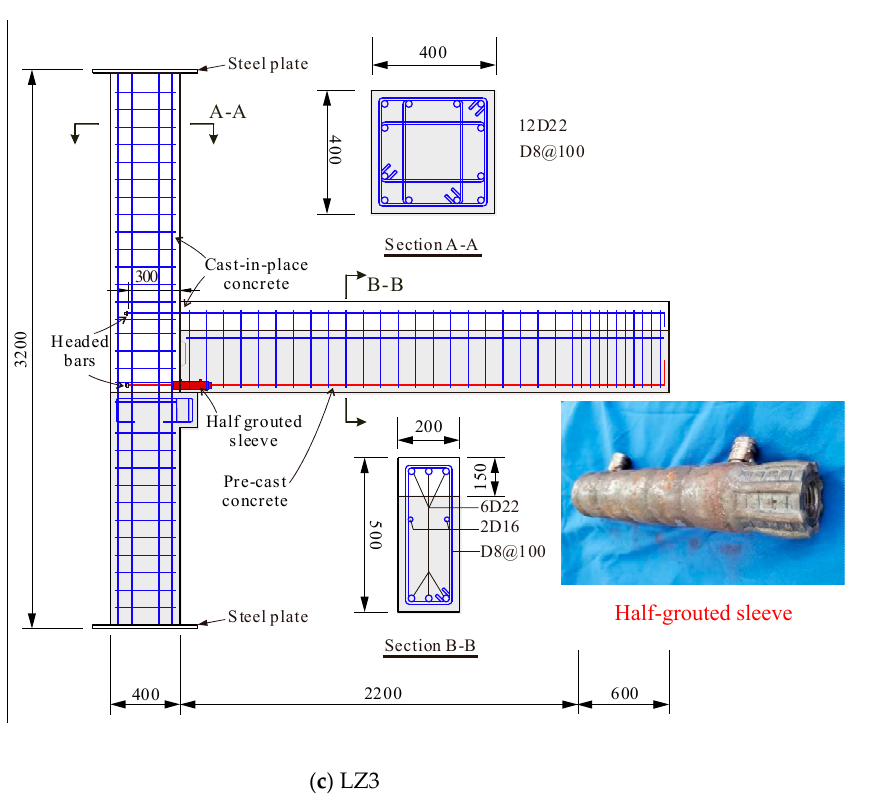
Figure 3. Dimensions and reinforcement details of the three specimens.